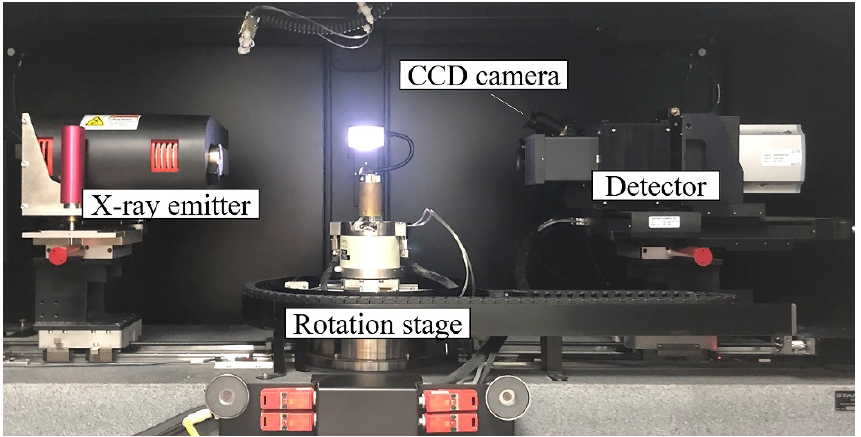
Figure 3. Internal features of Micro XCT-400